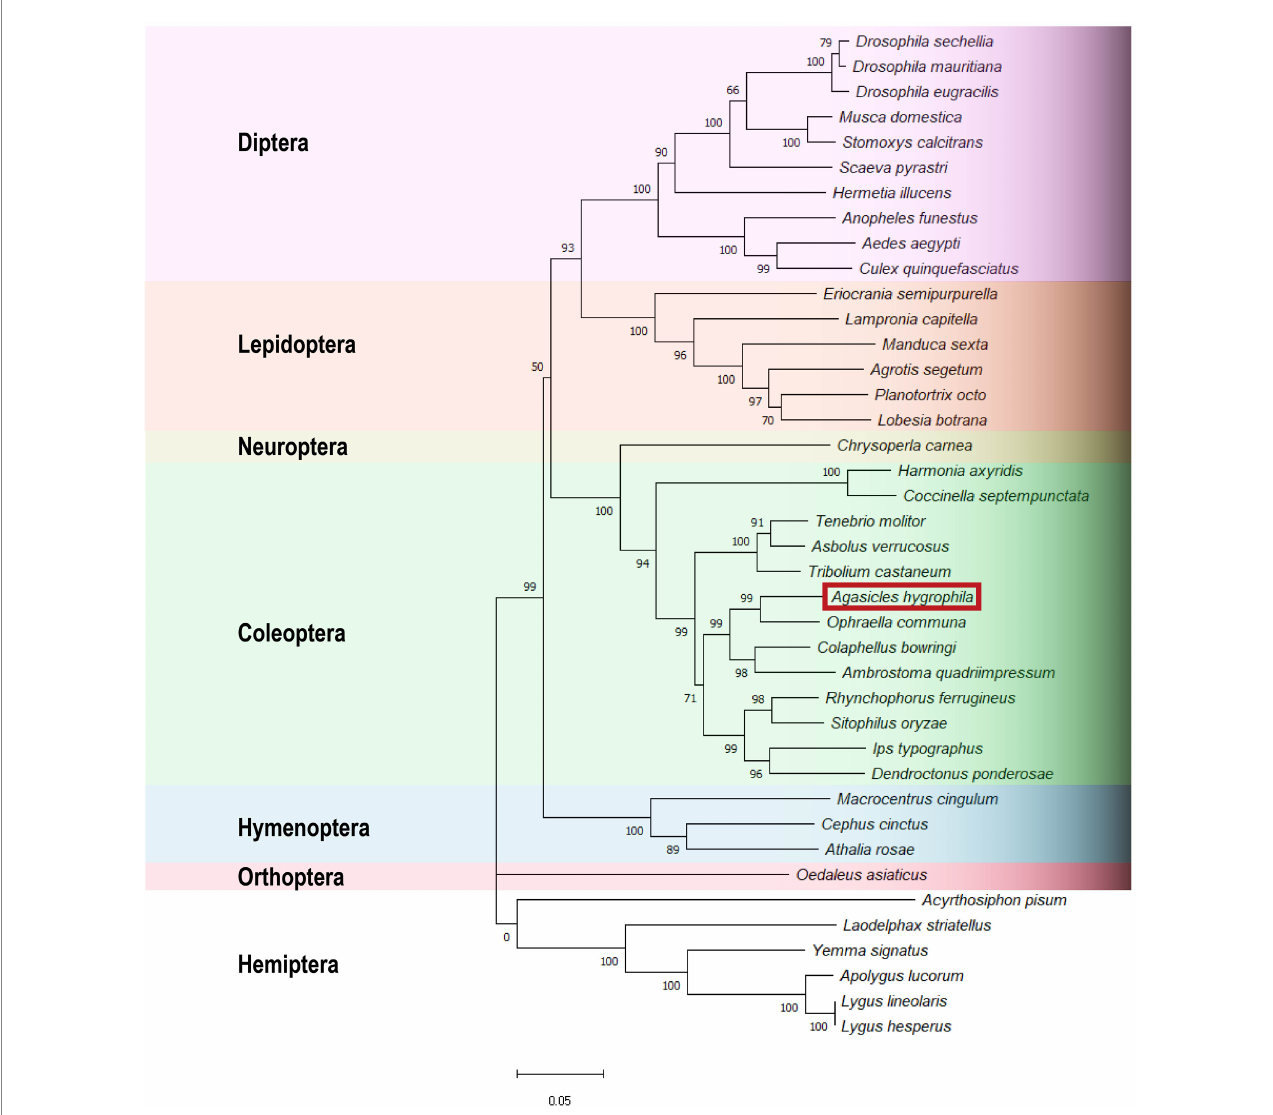
FIGURE 3 Neighbor-joining tree of Orco orthologs from different insects. Bootstrap support values based on 1,000 replicates are indicated. The branch lengths are proportional to the percentage of sequence difference (scale bar, 0.05% difference). The AhygOrco sequence is shown in the red box. The Orco amino acid sequences of all insects are listed in Appendix B. GenBank accession numbers of the other sequences are listed in Table